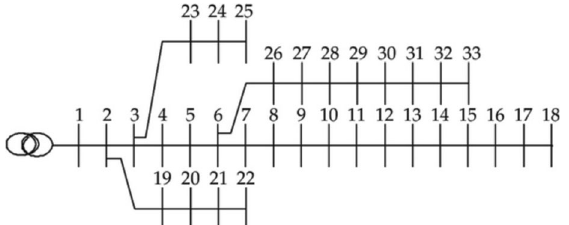
Fig. 2 Single line diagram of 33 bus test system